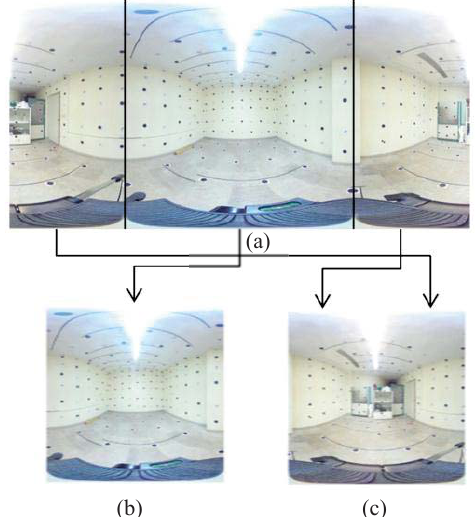
Figure 2. (a) Full spherical image, (b) central image (i.e. front lens), (c) side image (i.e. back lens).